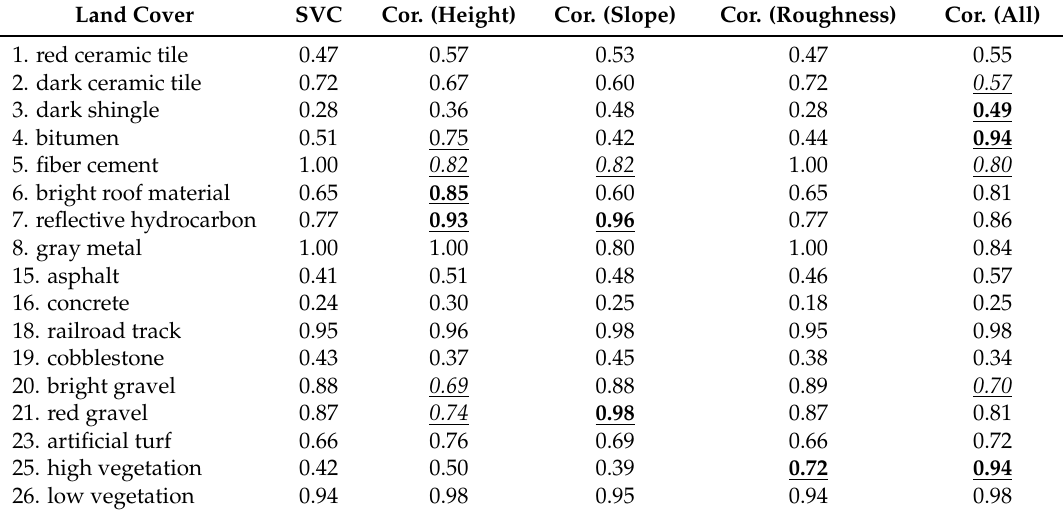
Table 4. Conditional kappas of level 2 shaded land cover classes for Support Vector Classification and for each LiDAR post-classification correction. Bold underlined values indicate significantly higher and italic underlined values indicate significantly lower conditional kappa’s (z = 0.05) compared to SVC before correction. Note that level 2 land cover numbering of Table 1 has also been used in this